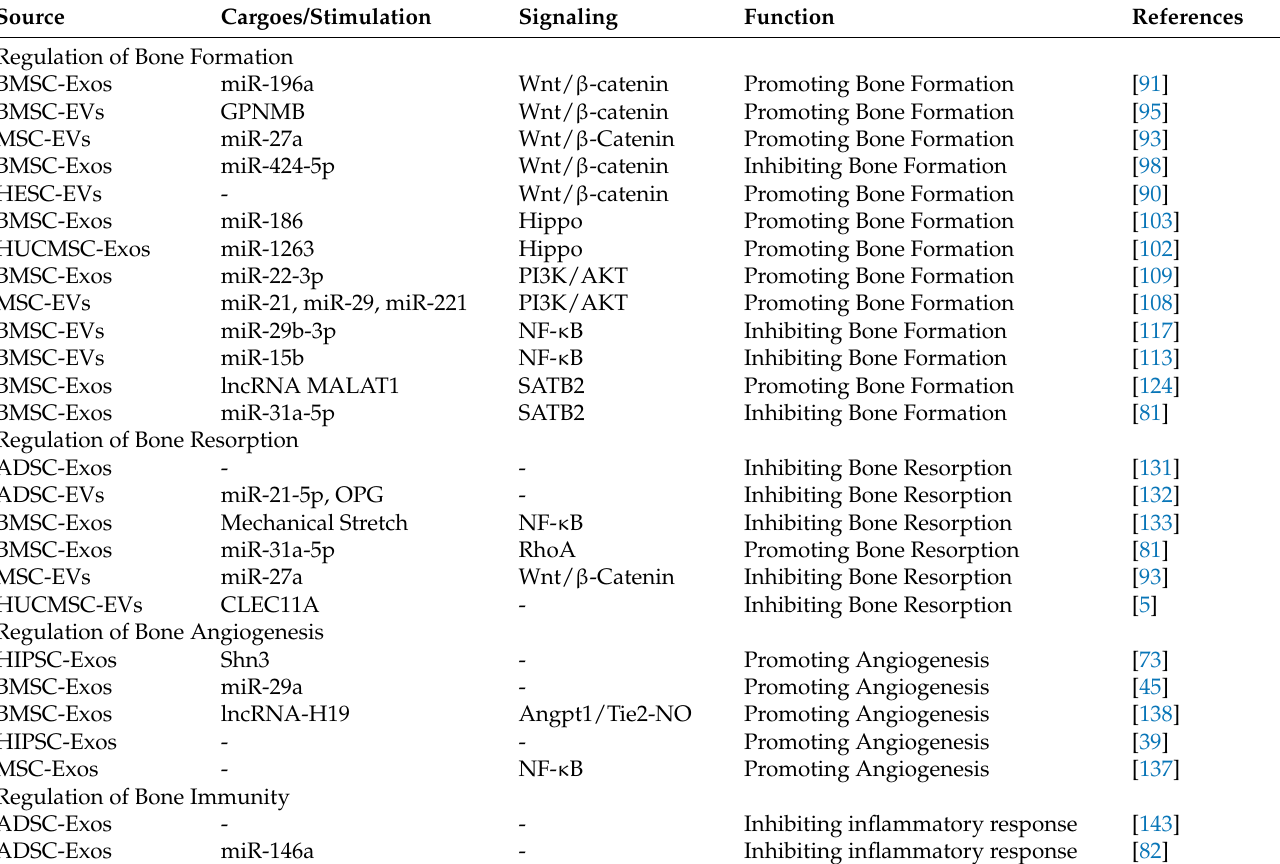
Table 1. Mechanisms of MSC-EVs in